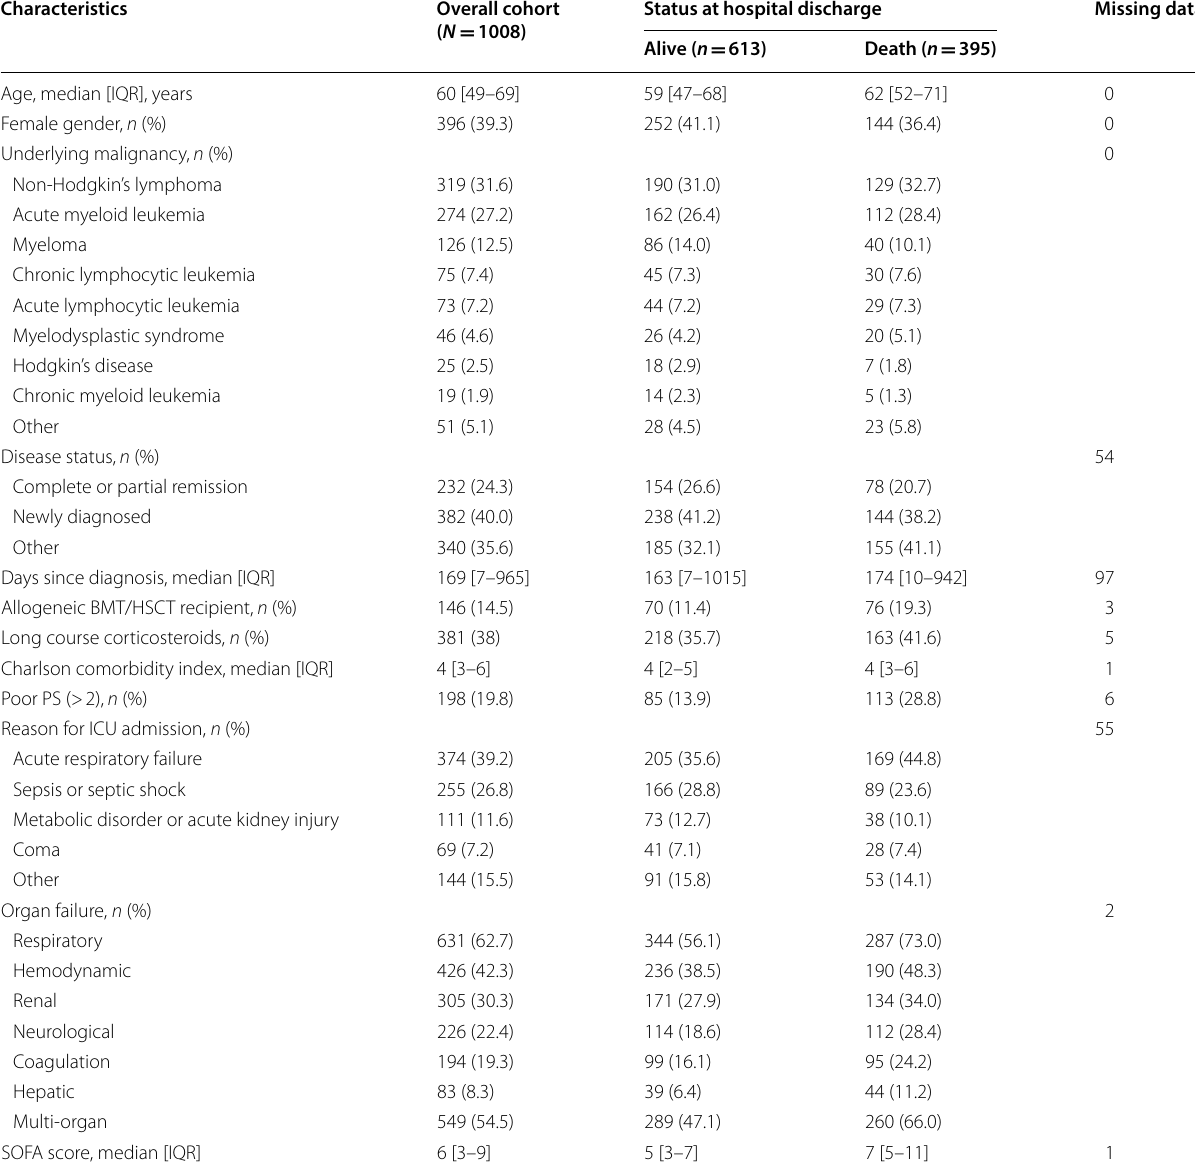
Table 1 Patients’ characteristics at ICU admission